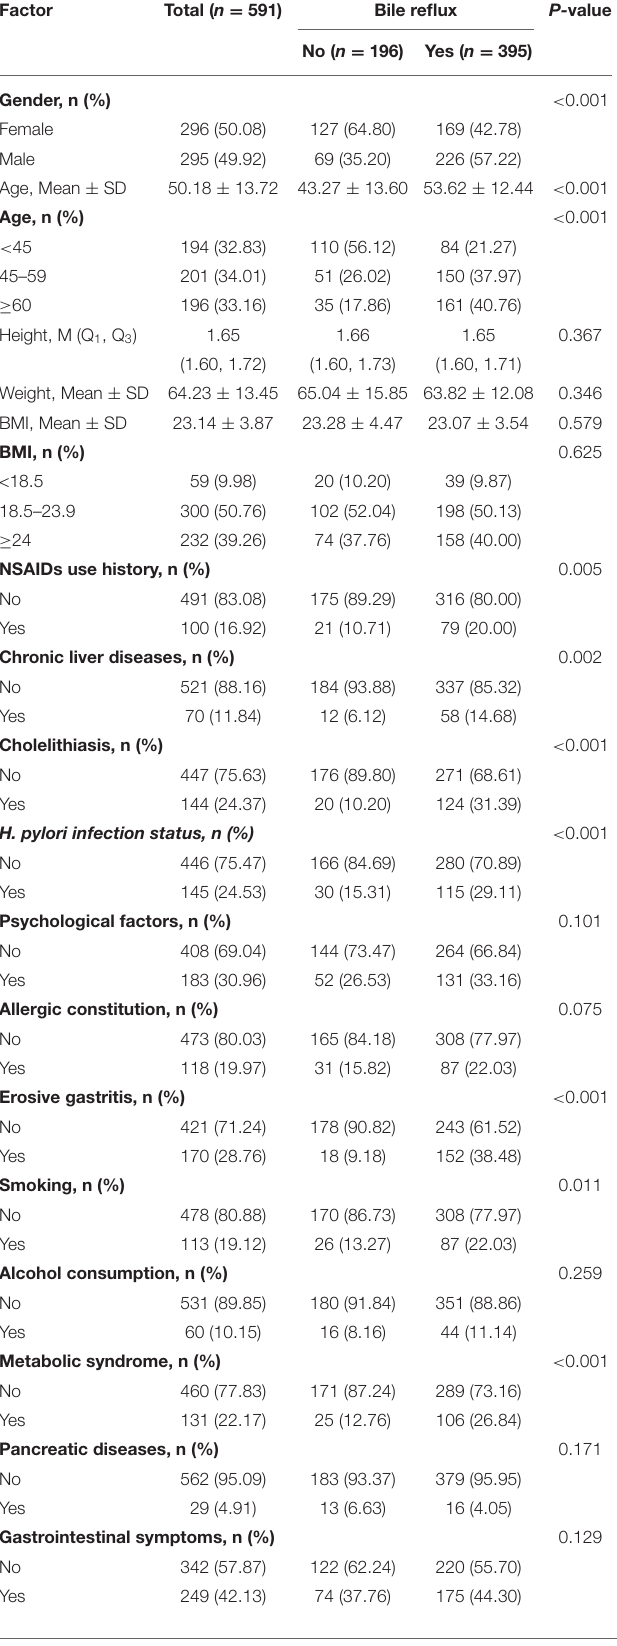
TABLE 1 | Univariate analysis of the risk factors for bile reflux in the training set. TABLE 2 | Logistic multivariate analyses of risk factors for primary bile reflux in the training